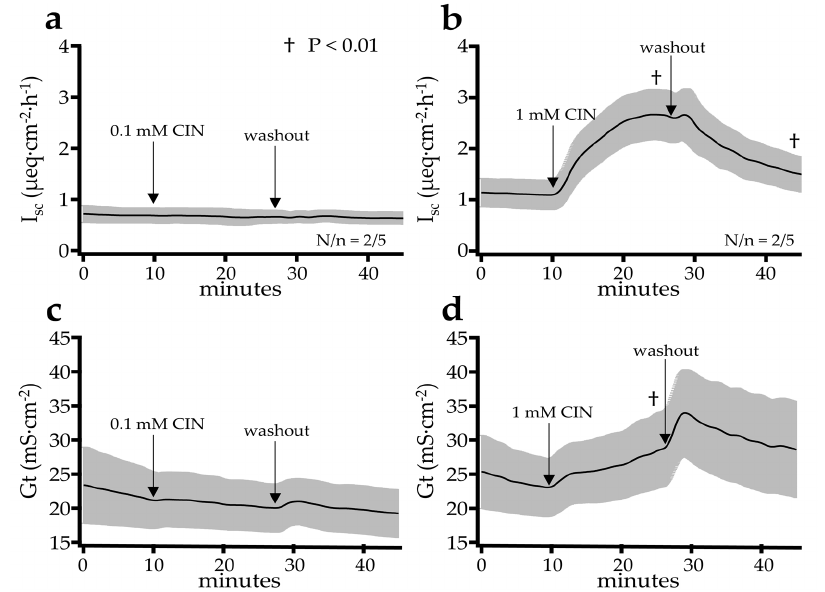
Figure 2. Effect of the TRPA1 agonist cinnamaldehyde at a concentration of 100 µmol·L − 1 ( a , c ) and 1 mmol·l − 1 ( b , d ) on I sc and G t in the Ussing chamber using the colonic tissue of young pigs (controlled in-house study). While the smaller concentration of 100 µmol·L − 1 was insufficient, after the addition of 1 mmol·L − 1 , a significant increase of the I sc and G t could be observed. After washout, the values dropped again. N/n = the number of animals/number of tissues, which was identical for G t and I sc.